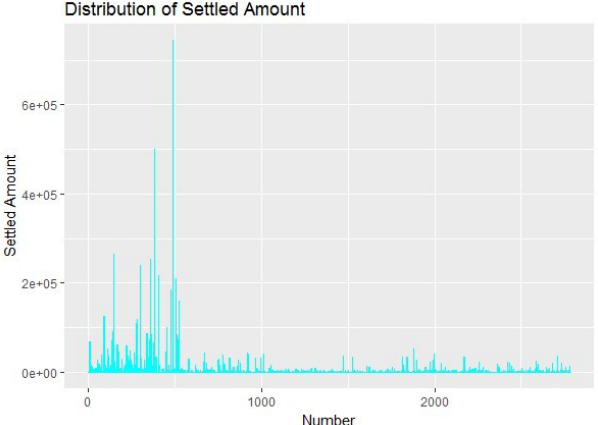
Figure 2. Distribution of the settled amount.